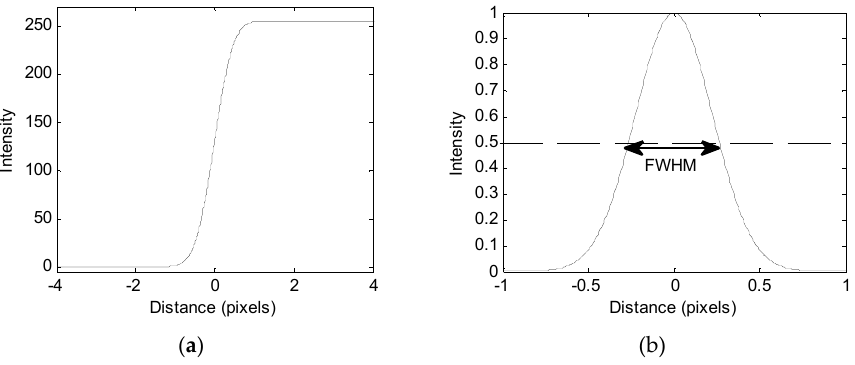
Figure 2. Edge response: ( a ) Fitted sigmoid function into the edge profile, and ( b ) first derivative of ( a ) with marked full width at half maximum.